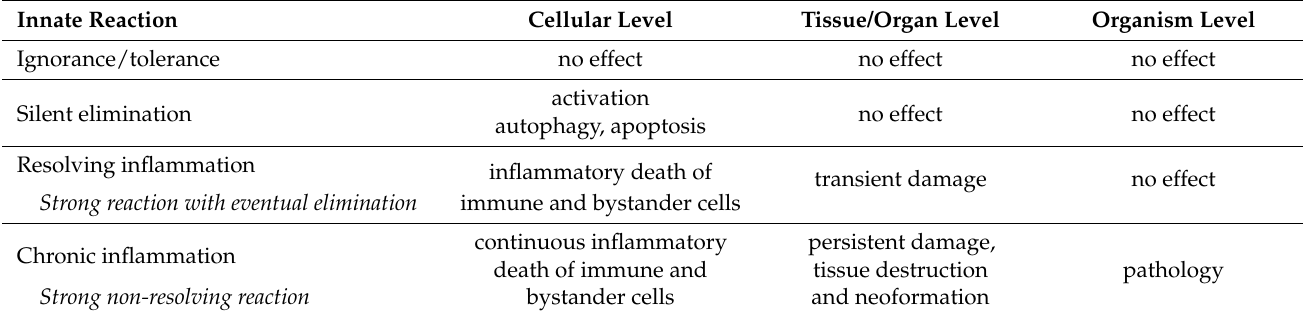
Table 1. The innate immune reaction to ENMs at the level of cells, tissues/organs and the entire organism. Innate Reaction Cellular